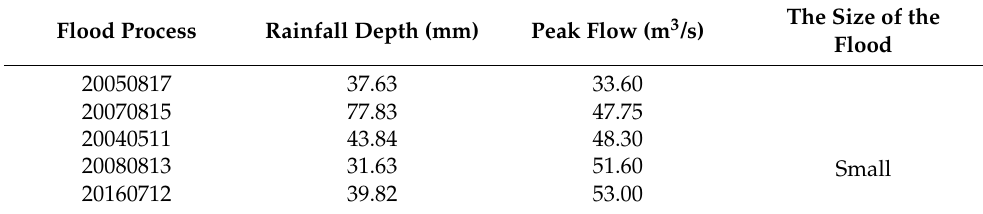
Table 3. The 21 typical flood processes (FPs) .